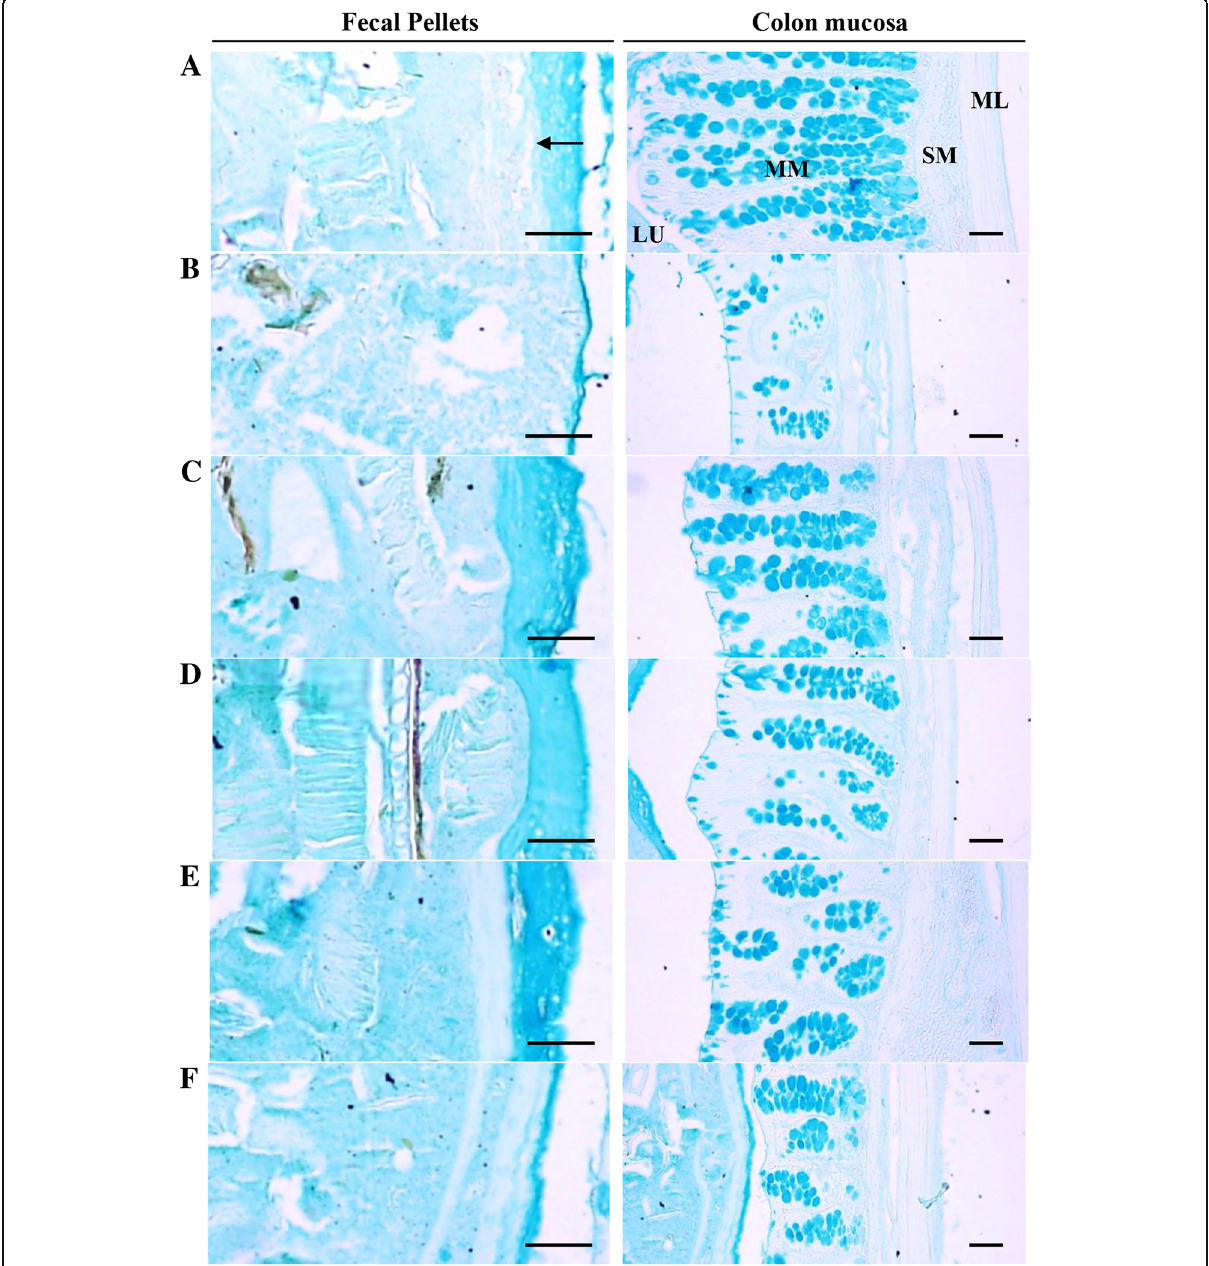
Fig. 4 Representative histological images of the colon contains fecal pellet, taken from vehicle, SP or FBe-treated normal rats. a = Intact vehicle control (Saline and distilled water administered intact vehicle control rats). b = LP control (LP 3 mg/kg and distilled water administrated constipation control rats). c = Reference (LP 3 mg/kg and SP 5 mg/kg administered rats). d = FBe 300 (LP 3 mg/kg and FBe the highest dosage 300 mg/kg administered rats). e = FBe 200 (LP 3 mg/kg and FBe the middle dosage 200 mg/kg administered rats). f = FBe 100 (LP 3 mg/kg and FBe the lowest dosage 100 mg/kg administered rats). FBe: Triple fermented barley extracts, test material; MM: Colonic mucosa; LU: Lumen; SM: Submucosa: ML: Muscular layer. Arrow indicated surface mucous thicknesses of fecal pellets measured. All alcian blue stain Scale bars = 120 μ